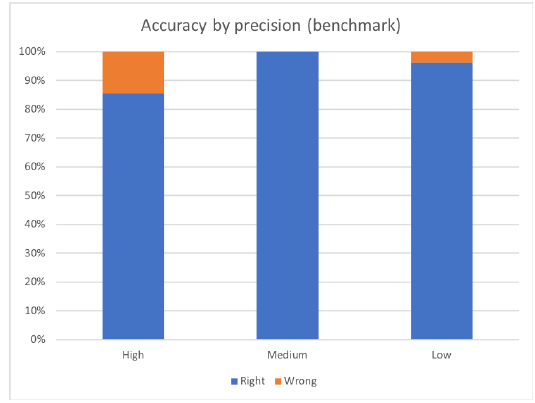
Figure 10. Accuracy by Precision Level Optimal